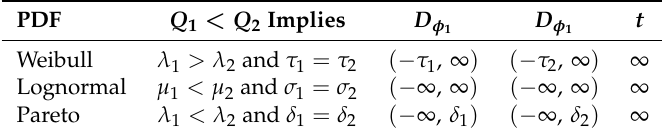
Table 1. Ordering of general Weibull, lognormal and two-parameter Pareto families for Theorem